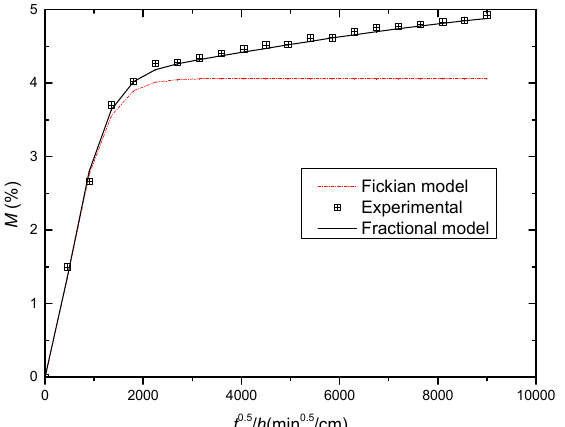
Figure 4. The comparison between experimental results and the fractional model by Equation (10) of the weight gain curve of resin during hygrothermal aging at 60 °C and 100%RH. The dash dot line is Fickian diffusion. Table 2. Parameters in time-fractional diffusion equation for neat resin.